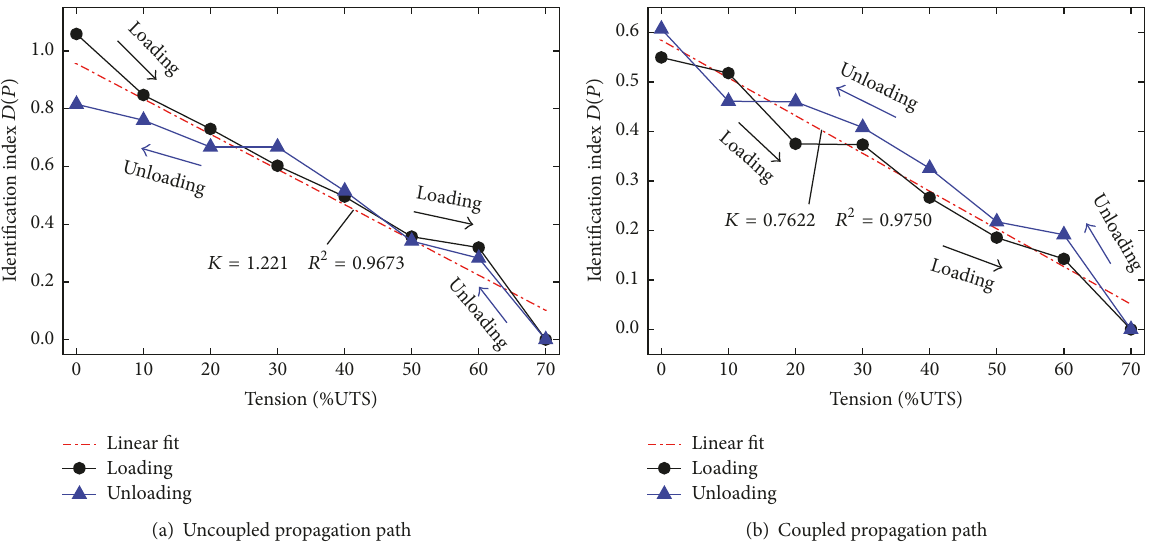
Figure 11: Proposed identification index and tension relationships for different long propagation